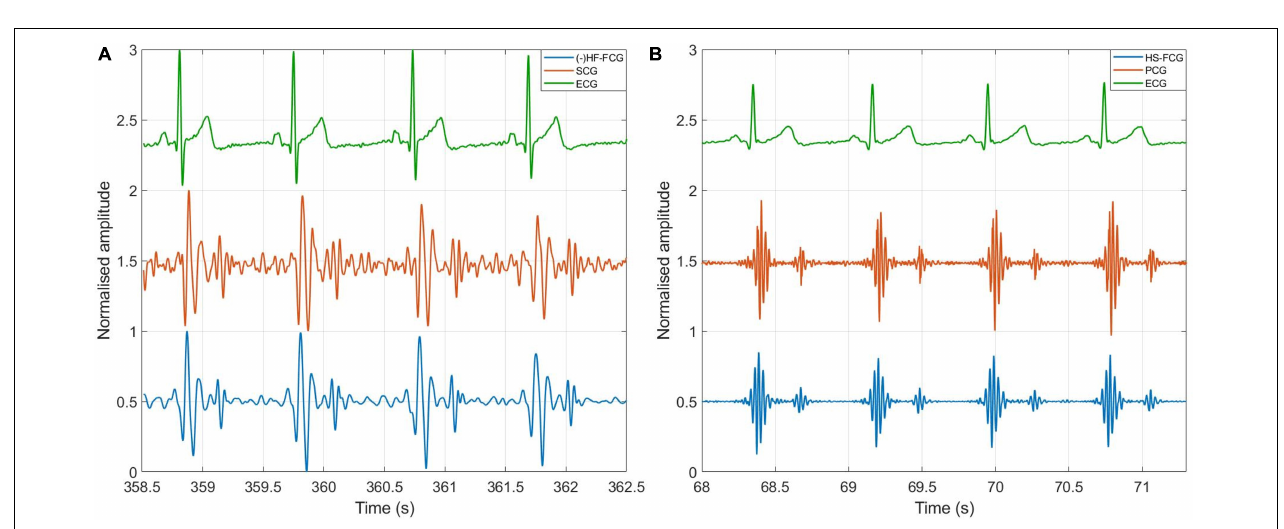
FIGURE 10 | Comparison of FCG with SCG and PCG. (A) Example of HF-FCG, SCG and ECG signals acquired simultaneously; (B) example of HS-FCG, PCG and ECG signals acquired simultaneously.